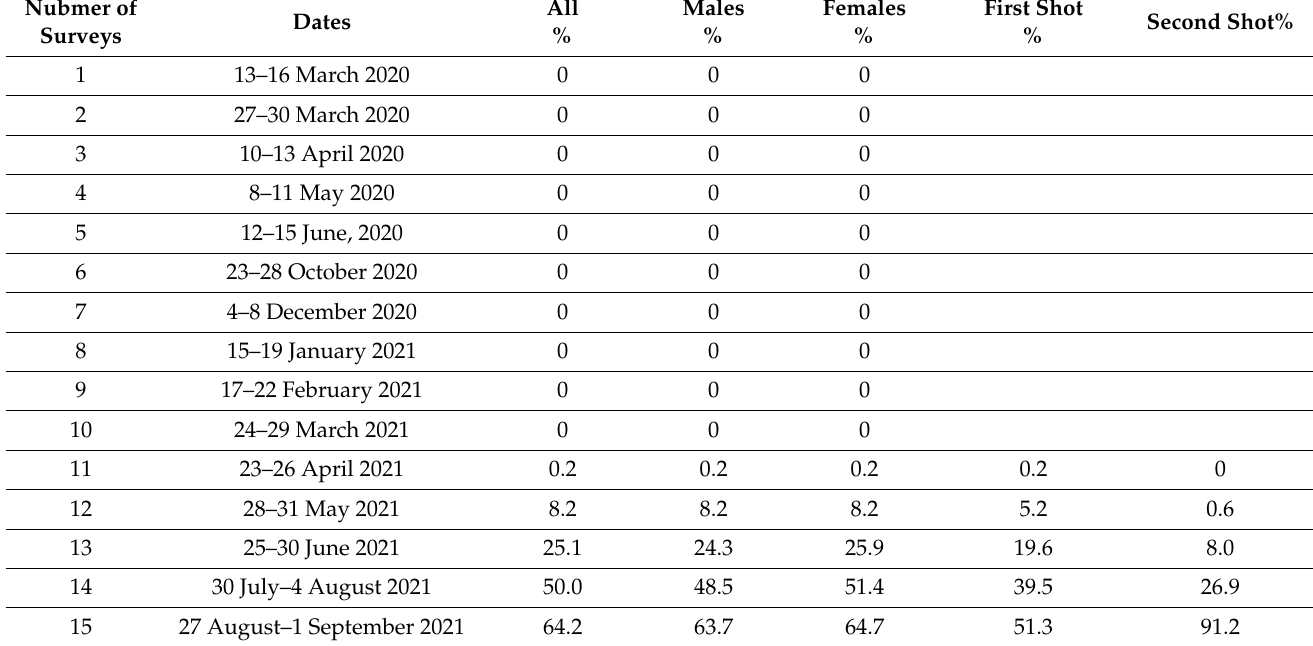
Table 2. Percentage of those who took the COVID-19